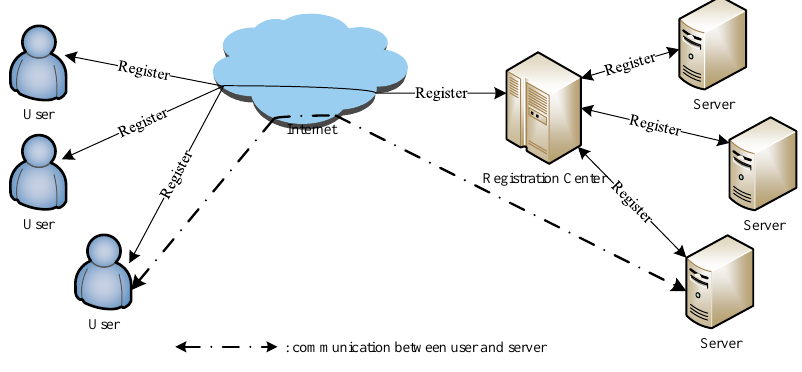
Figure 1. The architecture of the multi-server authentication system.